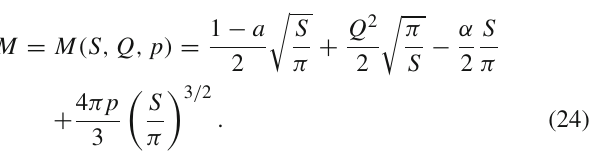
Fig. 3 The Hawking temperature T as a function of the